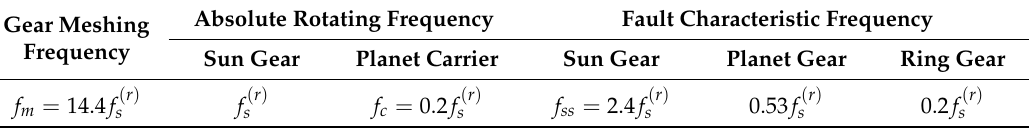
Table 4. Fault characteristic frequency of planetary